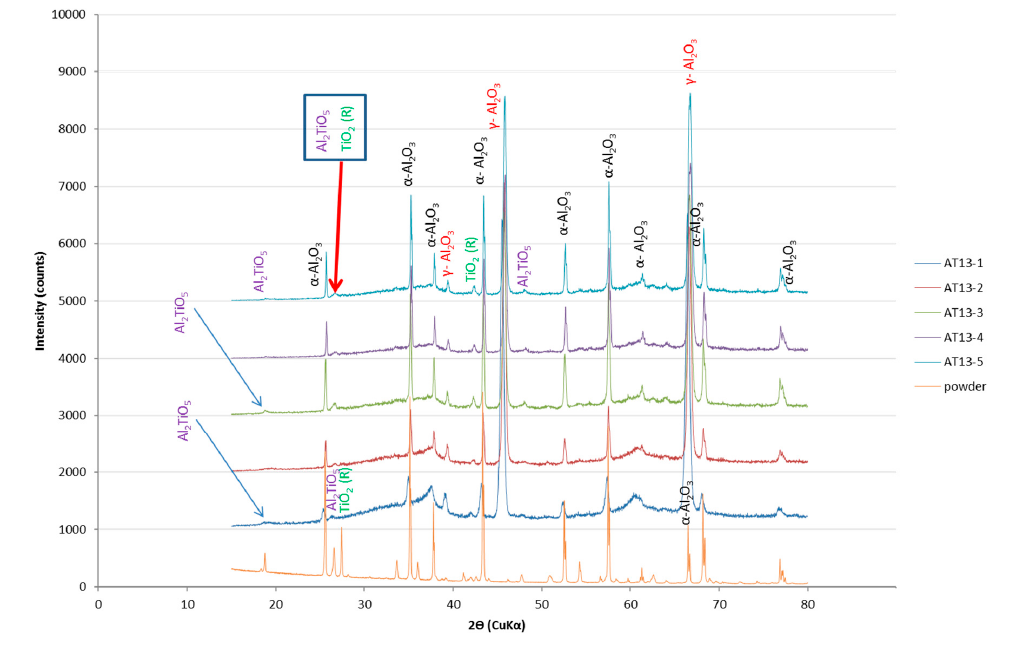
Figure 7. XRD of as-sprayed coatings and as-delivered powder.